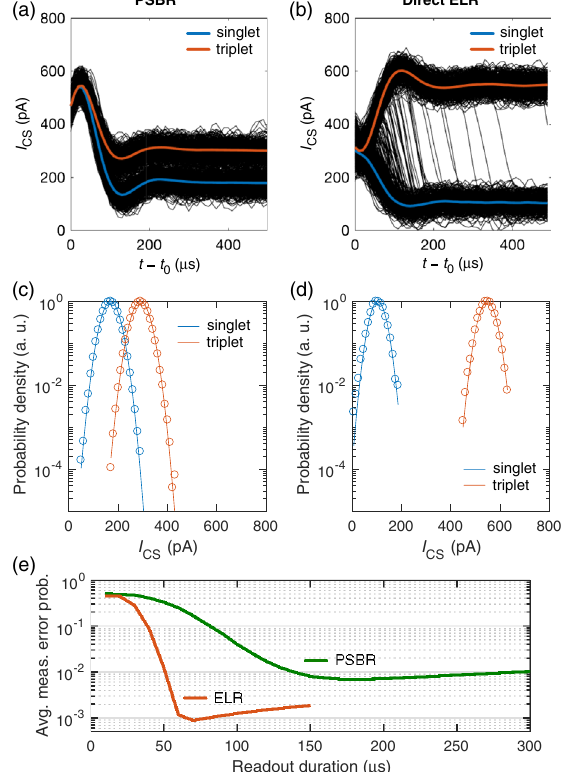
FIG. 5. (a,b) Single-shot time traces for the PSB readout and ELR of donor 2. The enhancement in signal is clearly visible for the ELR case. (c,d) Probability density of finding a certain CS current after the signal is stabilized for a 10 - μ s time bin. It shows the enhancement in signal, while the noise magnitude stays the same and is well modeled by a Gaussian fit with standard deviation 26.8 pA. (e) The error probability ¯ e , which first meas decreases as the readout duration is increased because of the reduced effect of noise in the state estimation. If the duration is too long, errors from the relaxation or excitation become the dominant source. The ELR shows a factor of 8 enhancement in charge measurement error, 2.3 reduction in measurement time, and 3.7 improvement in signal. The limiting factor to the detection time is the limited bandwidth of the system, which introduces a significant rise time to the signal, despite the large signal-to-noise ratio of the ELR for 10 - μ s time bins. This suggests that large improvements are still possible. TABLE II. Comparison of readout parameters between the PSBR and the direct ELR for donor 2. The reverse ELR does